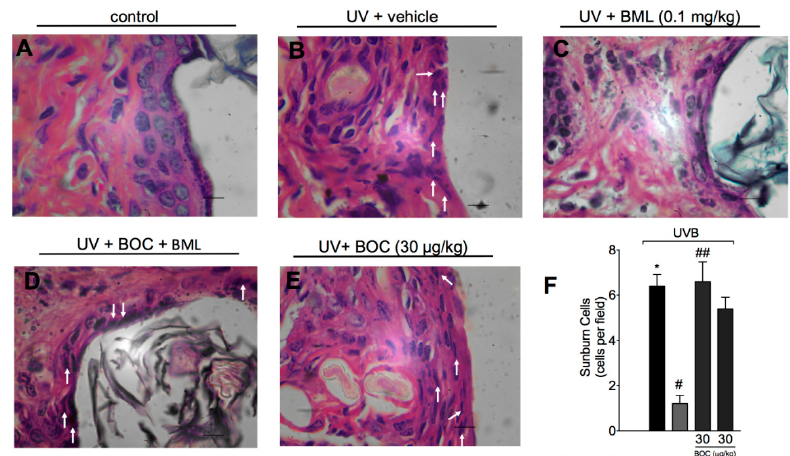
determined in samples dissected 12 h after the radiation and stained with H&E. Representative images of non-irradiated control ( A ), irradiated treated with vehicle ( B ), irradiated treated with 0.1 mg / kg of BML-111 ( C ), irradiated treated with BOC and BML-111 ( D ), and irradiated treated with BOC ( E ) groups are presented. Quantitative analysis of sunburn cells in experimental groups is presented per field in ( F ). Original magnification 100 × ; 100 µ m. Results are expressed as mean ± SEM and are representative of two independent experiments. One-way ANOVA followed by Tukey’s post-test * p < 0.05 compared to non-irradiated group, # p < 0.05 compared to irradiated vehicle-treated group, ## p < 0.05 compared to BML-111